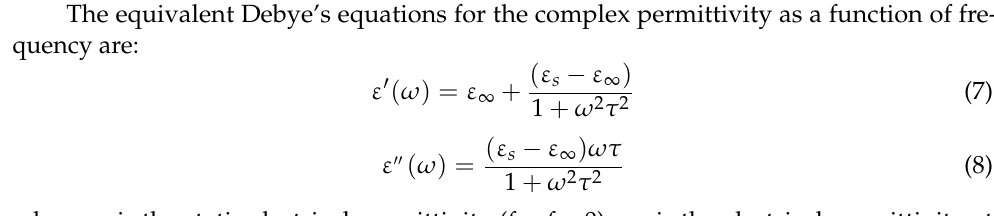
Figure 9. Dielectric losses of low-density polyethylene (LDPE) as functions of temperature and frequency. Dielectric breakdown measurement is a destructive diagnostic method used to char- acterize the dielectric strength of materials. It is an irreversible destructive phenomenon in solid insulation materials. This type of measurement is typically based on the applica- tion of an increasing electrical field until the solid insulation breaks. The measurements can be made with an oil tester using degassed insulating oil to avoid flashover. To perform the measurements, several electrode geometries, such as spherical or mushroom-type electrodes, can be used. It is important to recognize that this test must observe certain standards (for example, the ASTM D149 or IEEE Std-930 standards), since the obtained results are highly dependent on the measurement procedure. The breakdown field is cal- culated by dividing the voltage at which the sample has broken down by the thickness of the same sample. The Weibull cumulative probability function is most often used to pro- cess experimental data. The expression of the two-parameter Weibull distribution is given by: 𝑃(𝐸) = 1 − 𝑒𝑥𝑝 (− (cid:3436)𝐸 𝛼(cid:3440) (cid:3081) ) (10) where P ( E ) represents the probability of failure and E is the experimental dielectric strength. The form factor, β , indicates the dispersion of the data, while the scale parameter, α , indicates the electrical field, for which the probability of breakdown is 63.2%. This last parameter is commonly used as the material characteristic breakdown strength. The esti- mators of α and β for a given sample can be calculated using a weighted least squares regression method as recommended by the IEEE Std-930 or the maximum likelihood method, which is often more convenient, since it is commonly used in commercial soft-